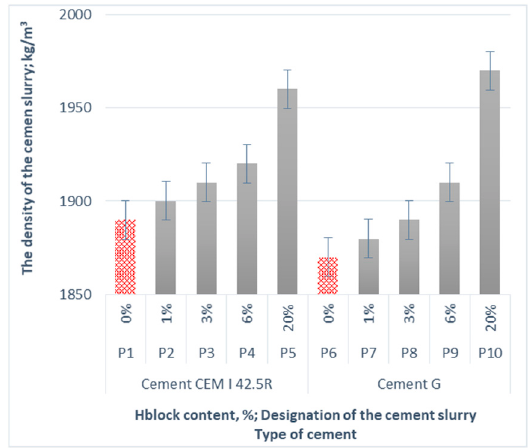
Figure 8. Summary of the density of the tested cement slurries.